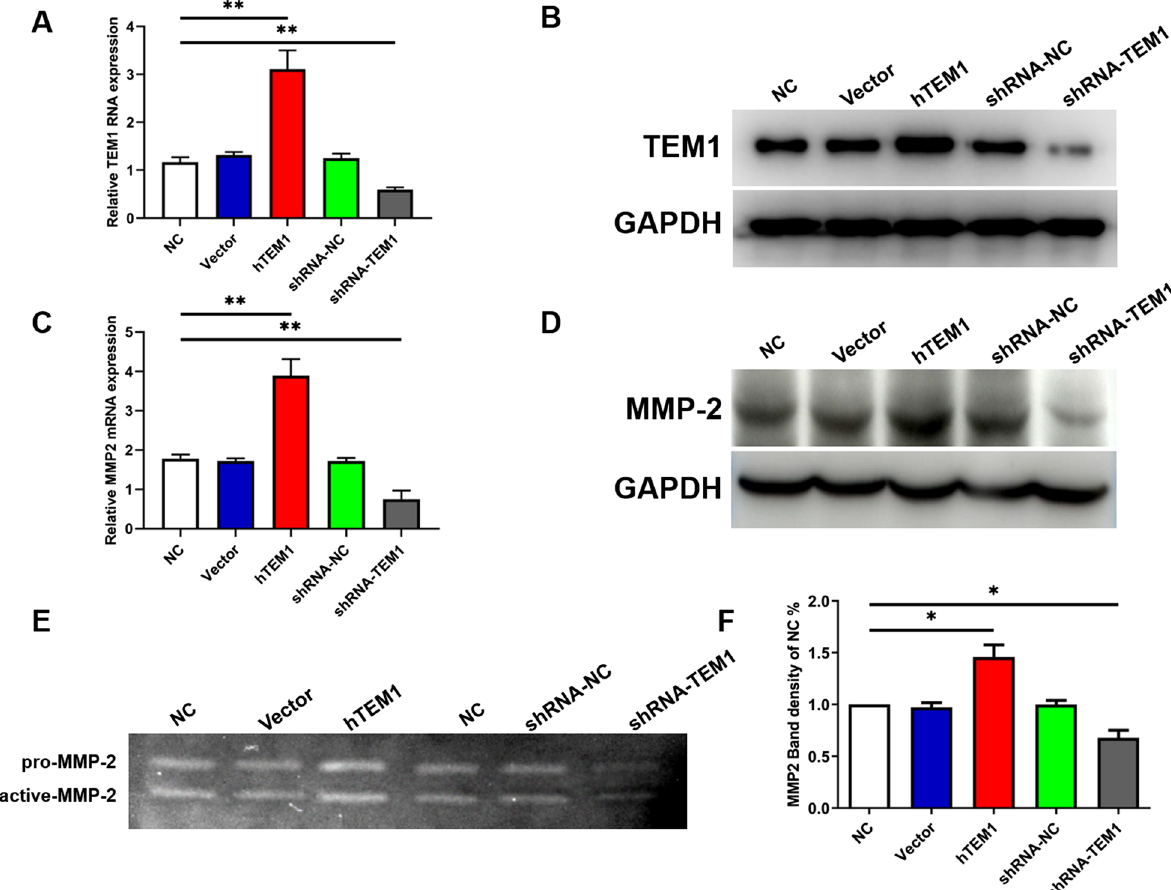
Fig. 2 The expression level of MMP-2 regulated by TEM1. Lentivirus-mediated hTEM1 MES-SA control vector (Vector), TEM1 overexpression vector (hTEM1), shRNA NC vector (shRNA-NC) and shRNA-TEM1 vector were transfected into MES-SA cell lines (NC) for the establishment of TEM1 overexpression and low expression MES-SA cell lines. TEM1 mRNA A and protein B expression were determined using qPCR and West- ern blot assays, respectively. The protein expression level of MMP-2 mRNA C and protein D in all cell lines. MMP-2 expression was upregu- lated in hTEM1 cells and downregulated in shRNA-TEM1 cells. Gelatin zymography showing elevated expression of MMP-2 in hTEM1 cells and decreased expression of MMP-2 in shRNA-TEM1 cells E , based on band density using Image J (F). *, P < 0.05; **, P <